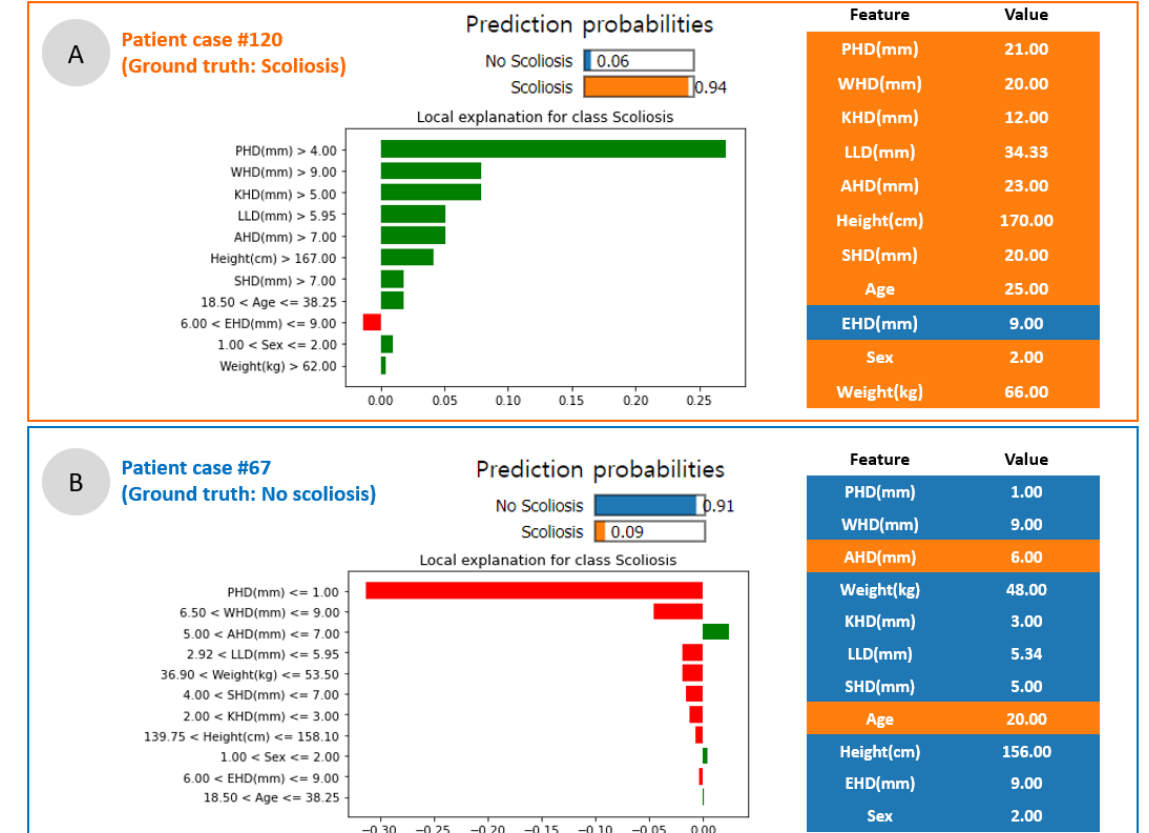
Figure 6. Scoliosis prediction for specific cases using local interpretation. ( A ) A 25-year-old woman with 94% prediction probability and ground truth of 1 (Cobb angle 11°). ( B ) A 20-year-old woman with 9% prediction probability and ground truth of 0 (Cobb angle 0°).